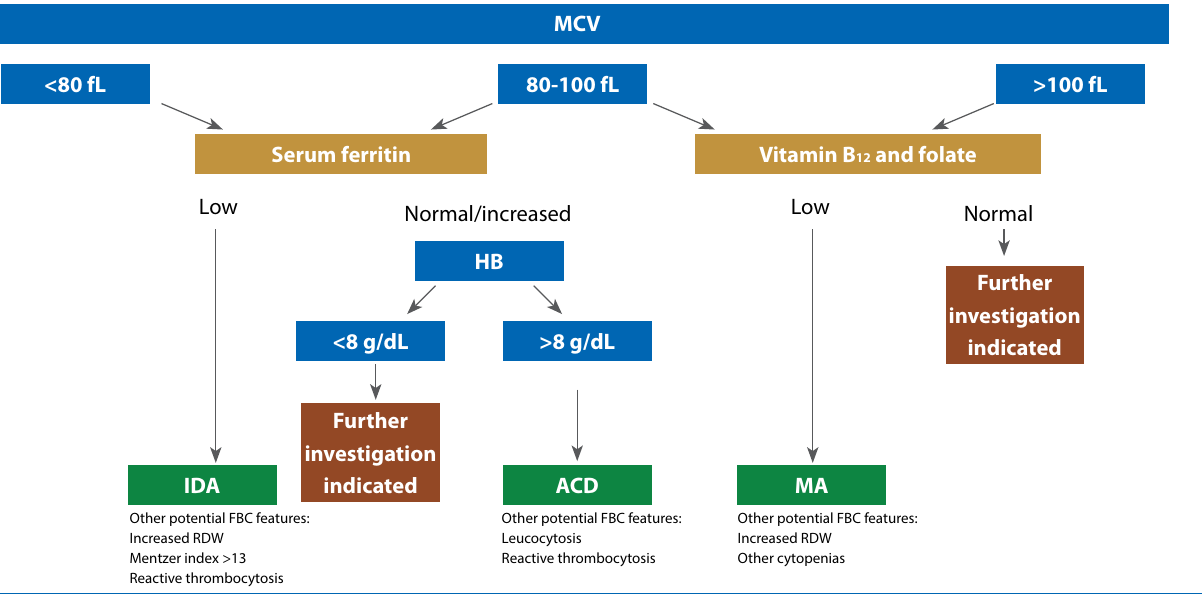
Figure 1. A basic approach to the first-line investigations in anaemia in primary practice. In all cases, once a nutritional deficiency has been confirmed, the cause of the nutritional deficiency should be